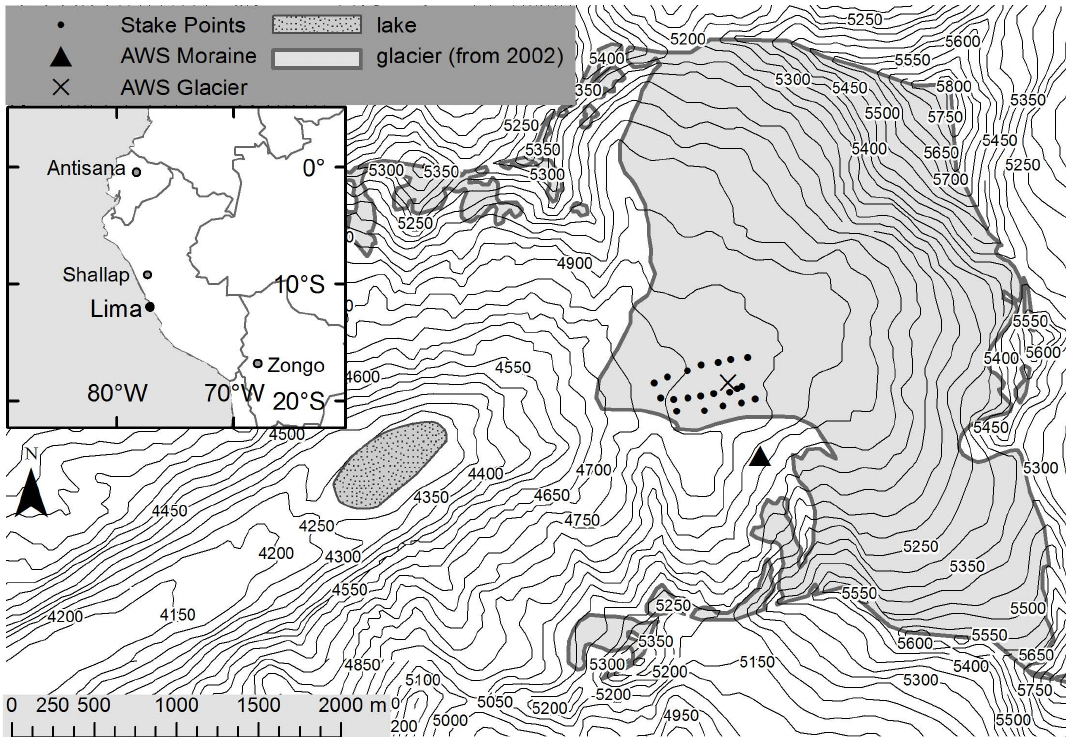
Fig. 1. Overview of Shallap Glacier located on the west side of the Peruvian Andes. Study sites on Antisana and Zongo glaciers are indicated in the inset